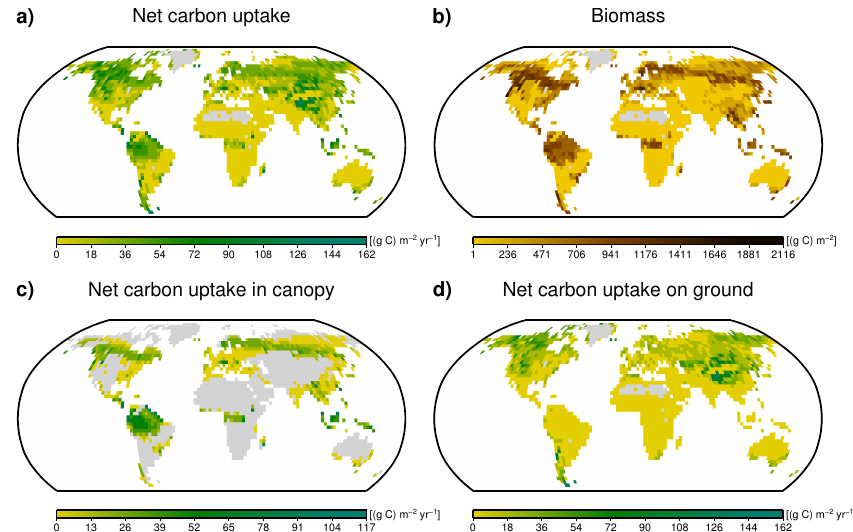
Figure A.1: Global maps of model estimates based on time averages of the last 100 yr of a Fig. A1. Global maps of model estimates based on time averages of the last 100yr of a 2000-yr run with 3000 initial strategies. The estimates 2000-yr run with 3000 initial strategies. The estimates shown in a) to d) are based on the shown in (a–d) to are based on the maximum-weighting method while the ones shown in Fig. 5 are based on the average-weighting method. “maximum” weighting method while the ones shown in Fig. 5 are based on the “average” Areas where no strategy has been able to survive are shaded in grey. weighting method. Areas where no strategy has been able to survive are shaded in grey.